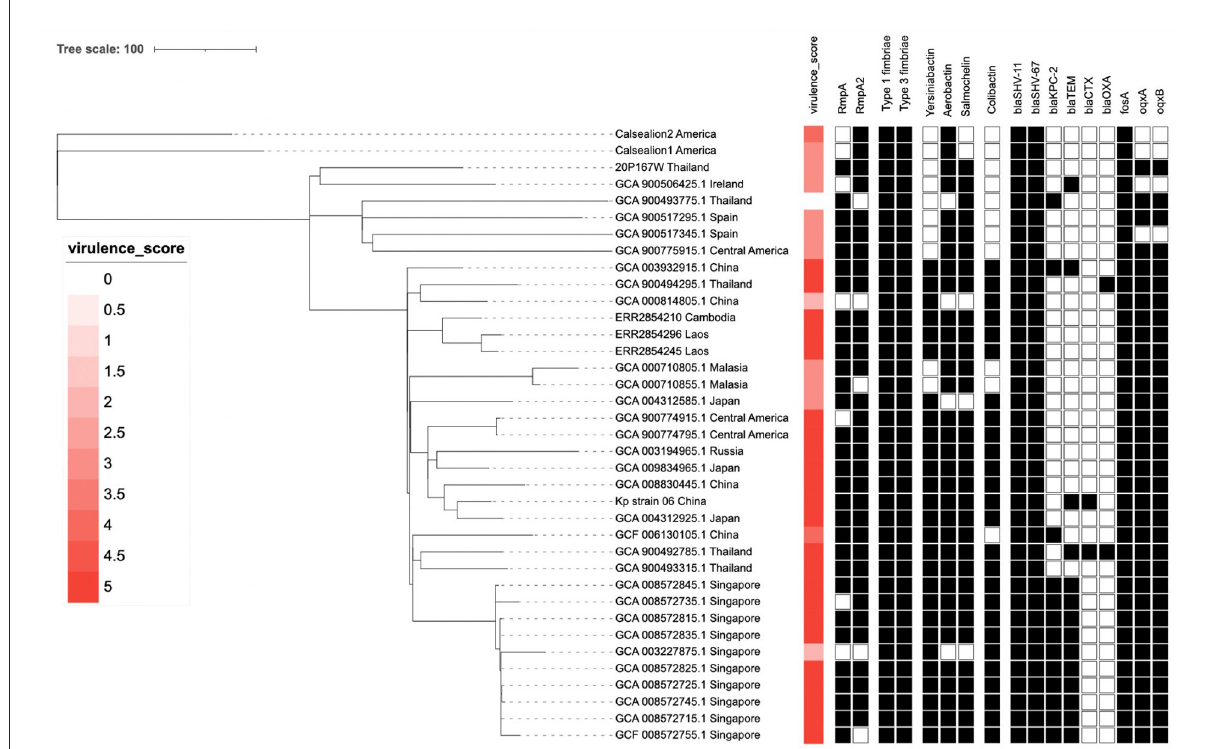
FIGURE4 The phylogenetic tree of 37 Klebsiella pneumoniae ST65 built from publicly available plus one isolate from this study. The tree was based on core single-nucleotide polymorphisms. The marmoset isolate from Thailand (20P167W) was grouped together with the isolate from Ireland.